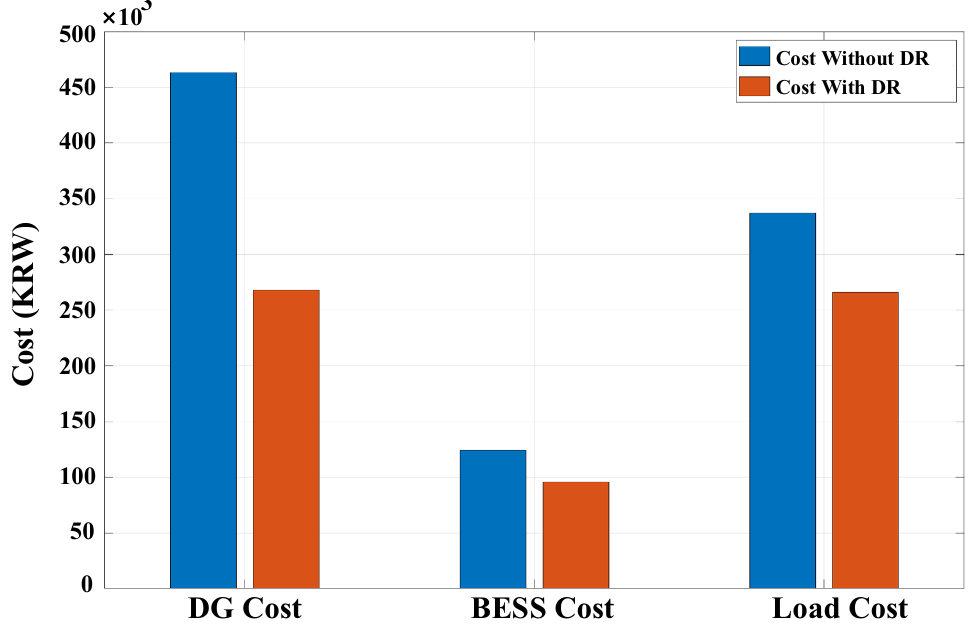
Figure 12. Comparison of DG, BESS, and load consumption cost for understudy day with and without DR.